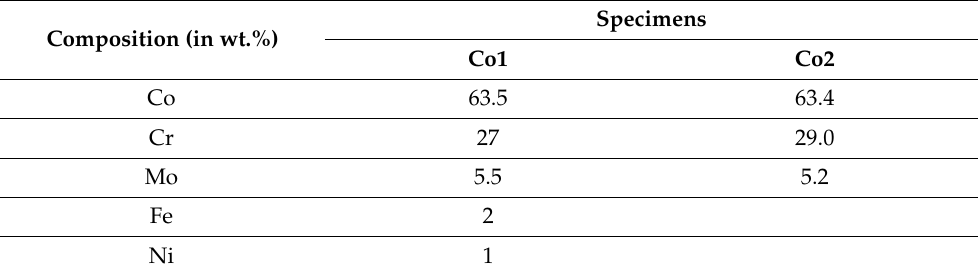
Table 2. CoCr dental material